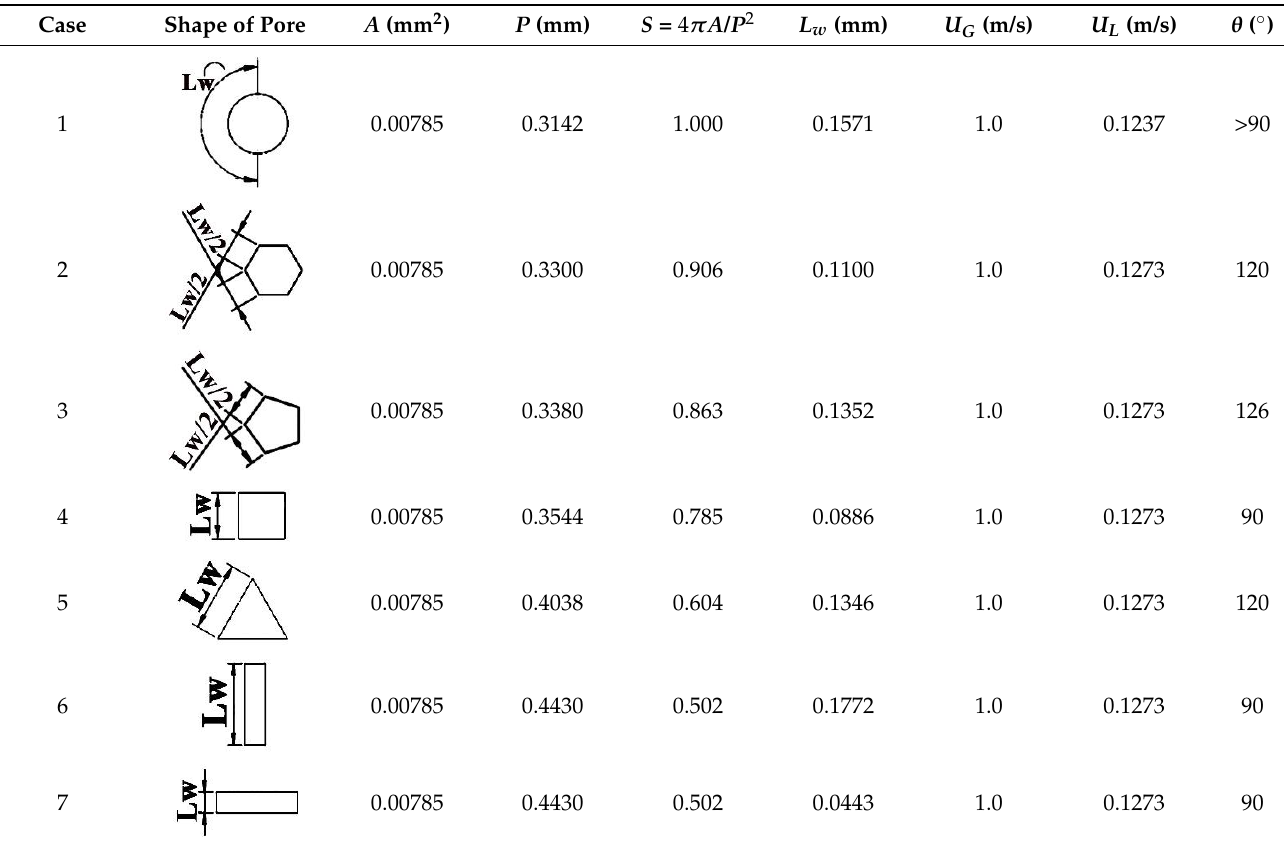
Table 1. The pore shape parameter with area kept constant in all cases.